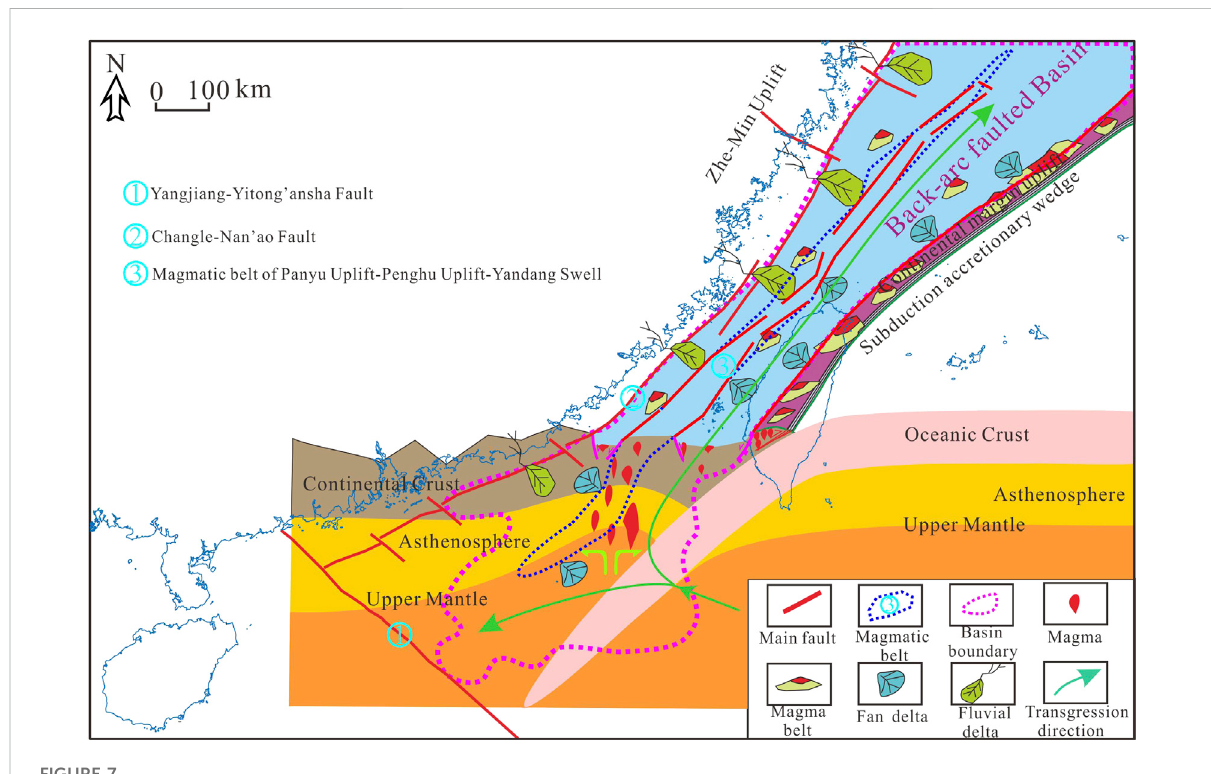
Plane view of the Late Cretaceous Basin (pink dotted line) and transgression direction (green arrow lines) in the NSCS-SECS, as well as the sedimentary system in the SECS. In the vertical section, we show the deep structural features, the magma activity, and the basin formation mechanism (modi fi ed from Zhou et al., 2005; Yi et al., 2012; Wu, 2014; Wang et al.,